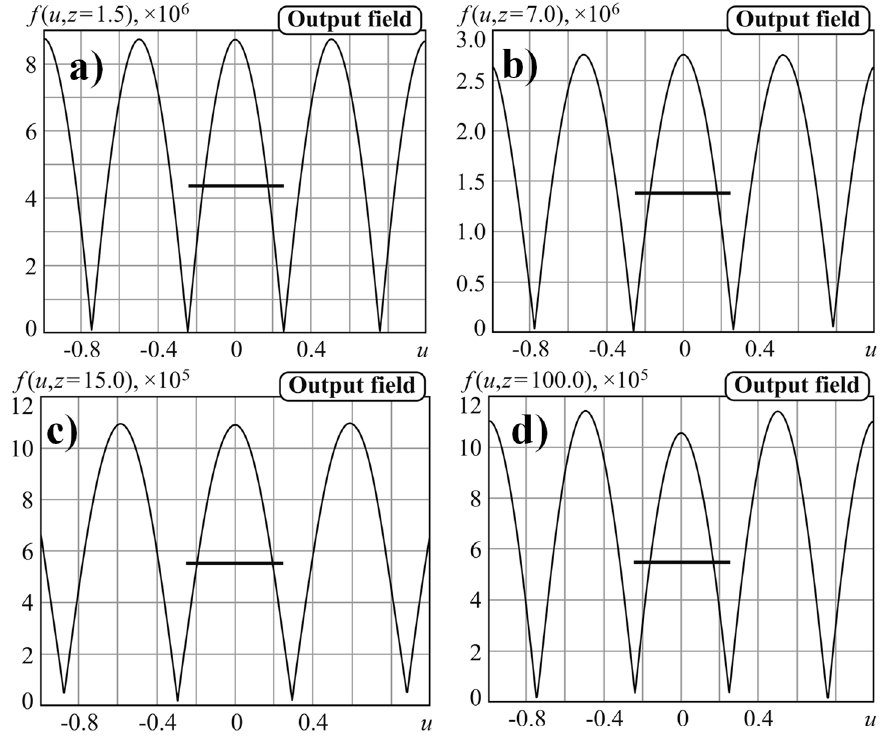
Figure 5. Field amplitude of Equation (1) propagated at the distance ( a ) z = 1.5 λ , ( b ) z = 7 λ , ( c ) z = 15 λ , ( d ) z = 100 λ .